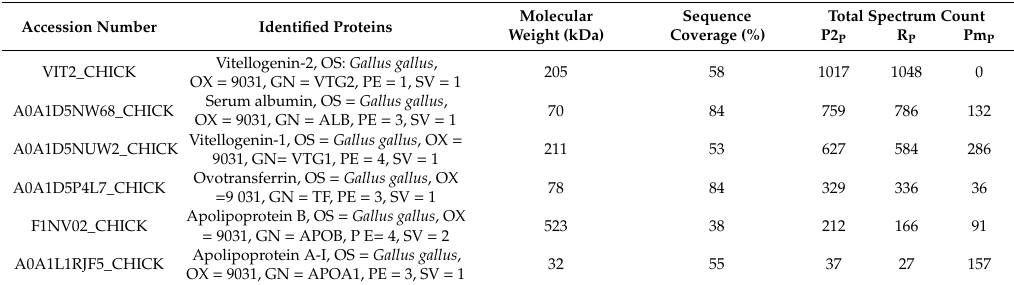
Table 4. Proteomic analysis of fractions generated from pressure-treated granules: plasma P2 P , UF-retentate R P and UF-permeate Pm P